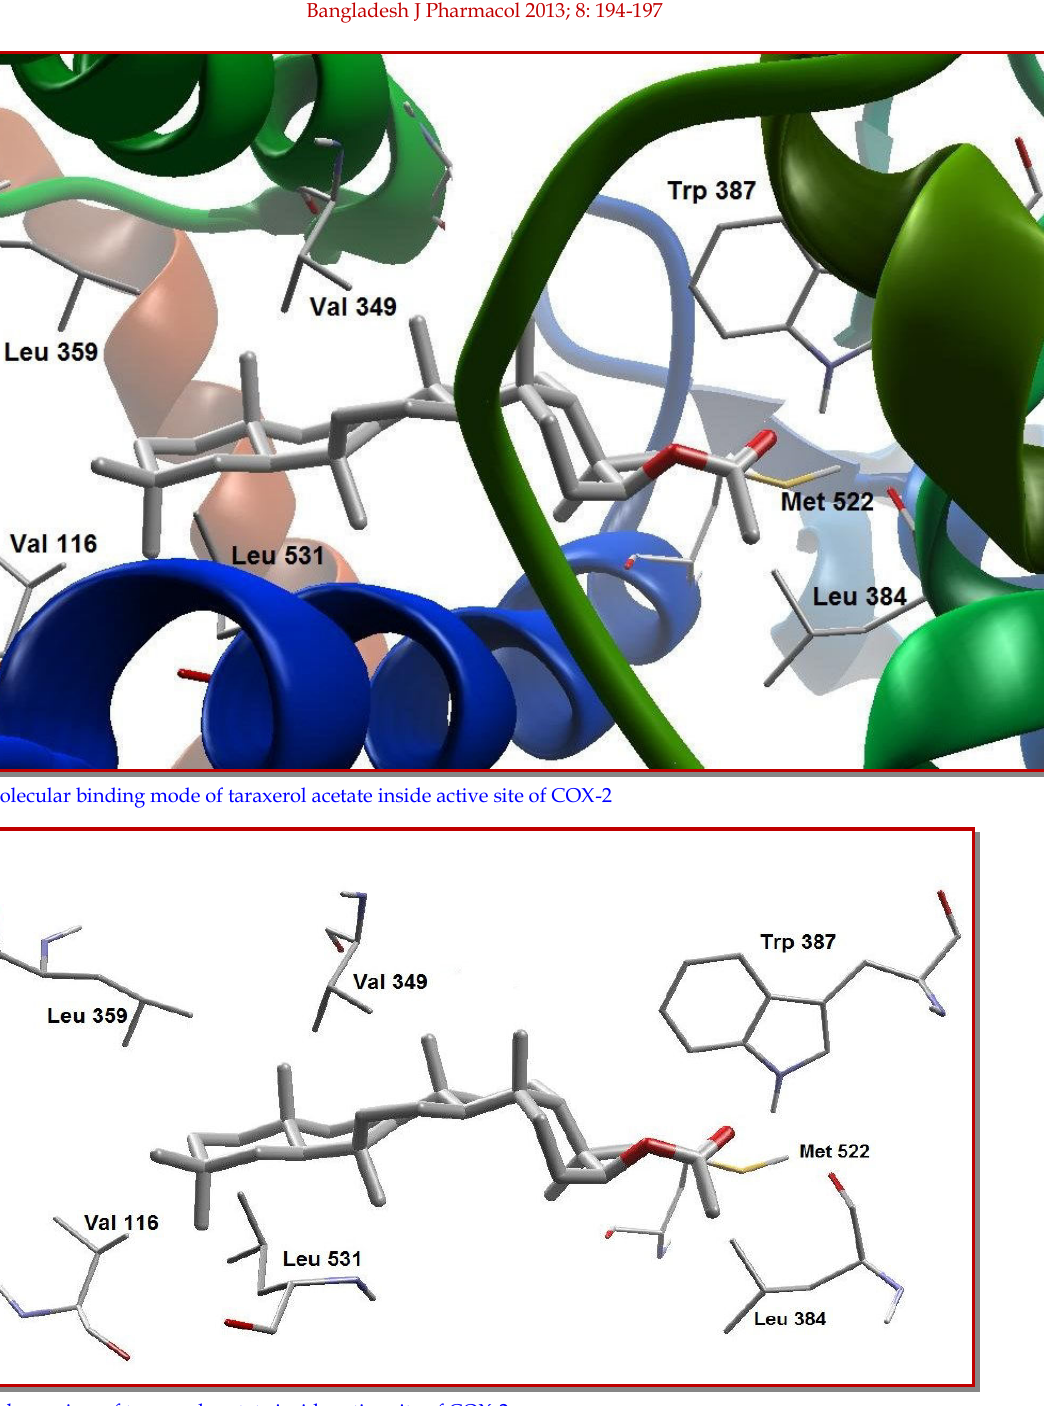
Figure 3: A closer view of taraxerol acetate inside active site of